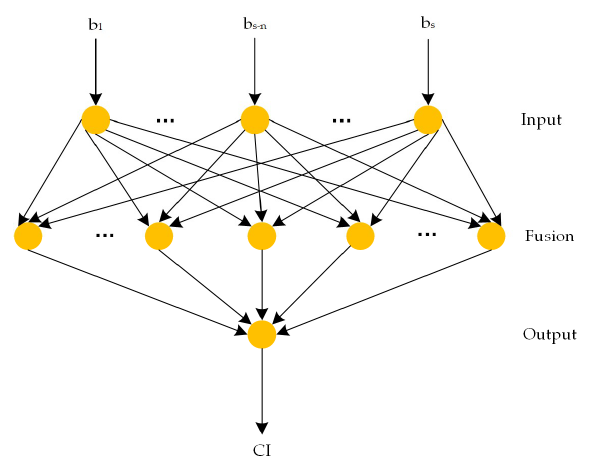
Figure 3. Probabilistic neural network model.